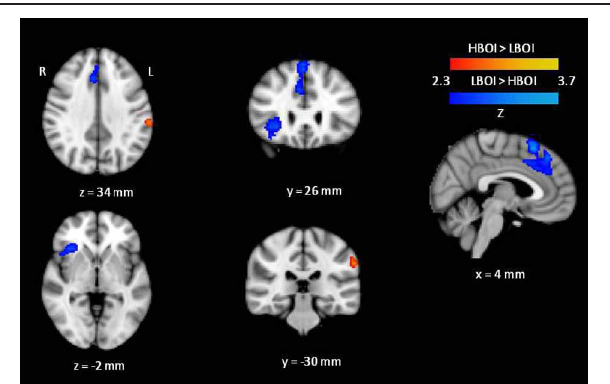
FIGURE 1 | Cortical activation maps displaying results of the high BOI (HBOI) versus low BOI (LBOI) contrasts. Regions showing greater activation for high BOI compared to low BOI are shown in orange. Regions showing greater activation for low BOI compared to high BOI are shown in